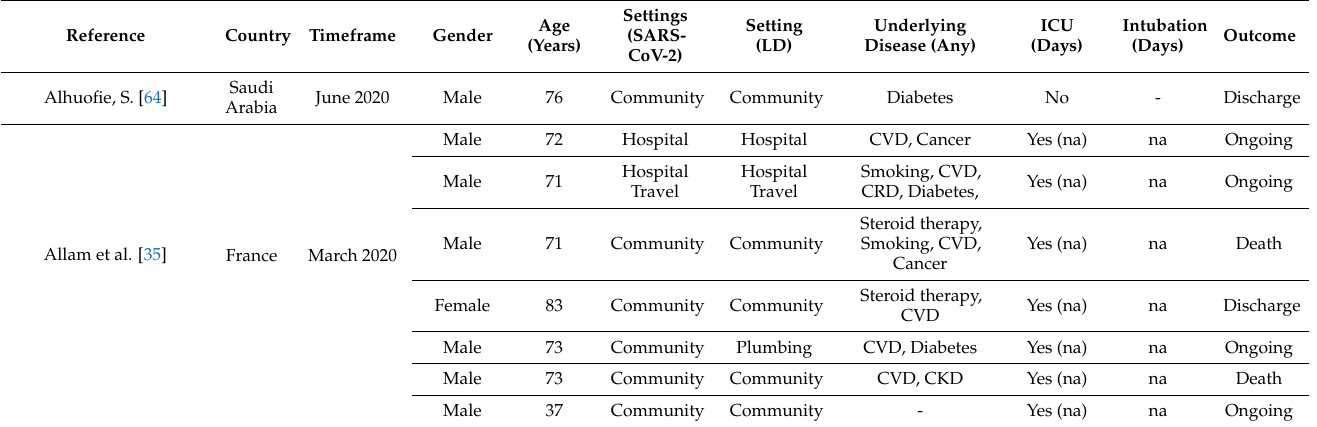
Figure A2. Border-enhanced funnel plot for studies included in the meta-analysis ( a ), and the corresponding radial plot ( b ). Visual inspection of the contour-enhanced funnel plot suggested substantial evidence of publication bias, but this was substantially ruled out by the Egger test (i.e., t = − 1.05, df = 12, p -value = 0.3131). On the other hand, in radial plots, the studies were substantially scattered across the regression line, suggesting no significant small study effect. Table A1. Summary of case reports on SARS-CoV-2 and Legionnaires’ disease (LD) co-infection. Note: ICU = intensive care unit; CVD = cardiovascular disease; CKD, chronic kidney disease; na = not available.